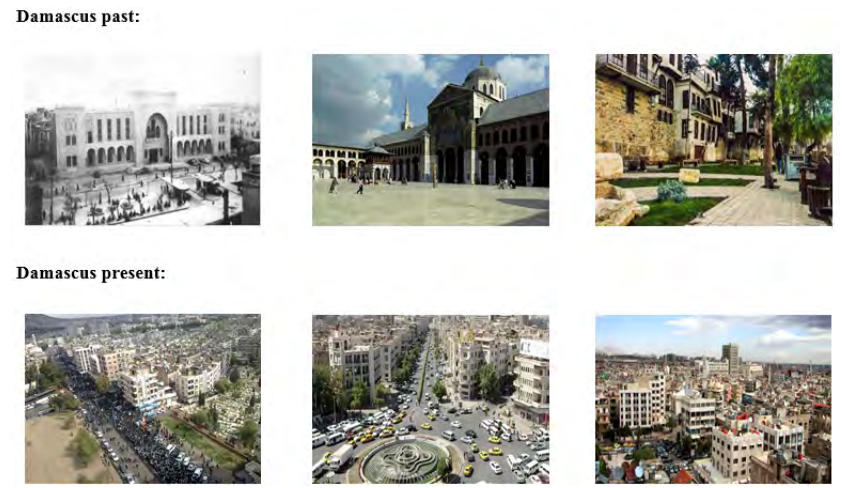
Figure 3. New Urban Identity for Damascus ( past –present)